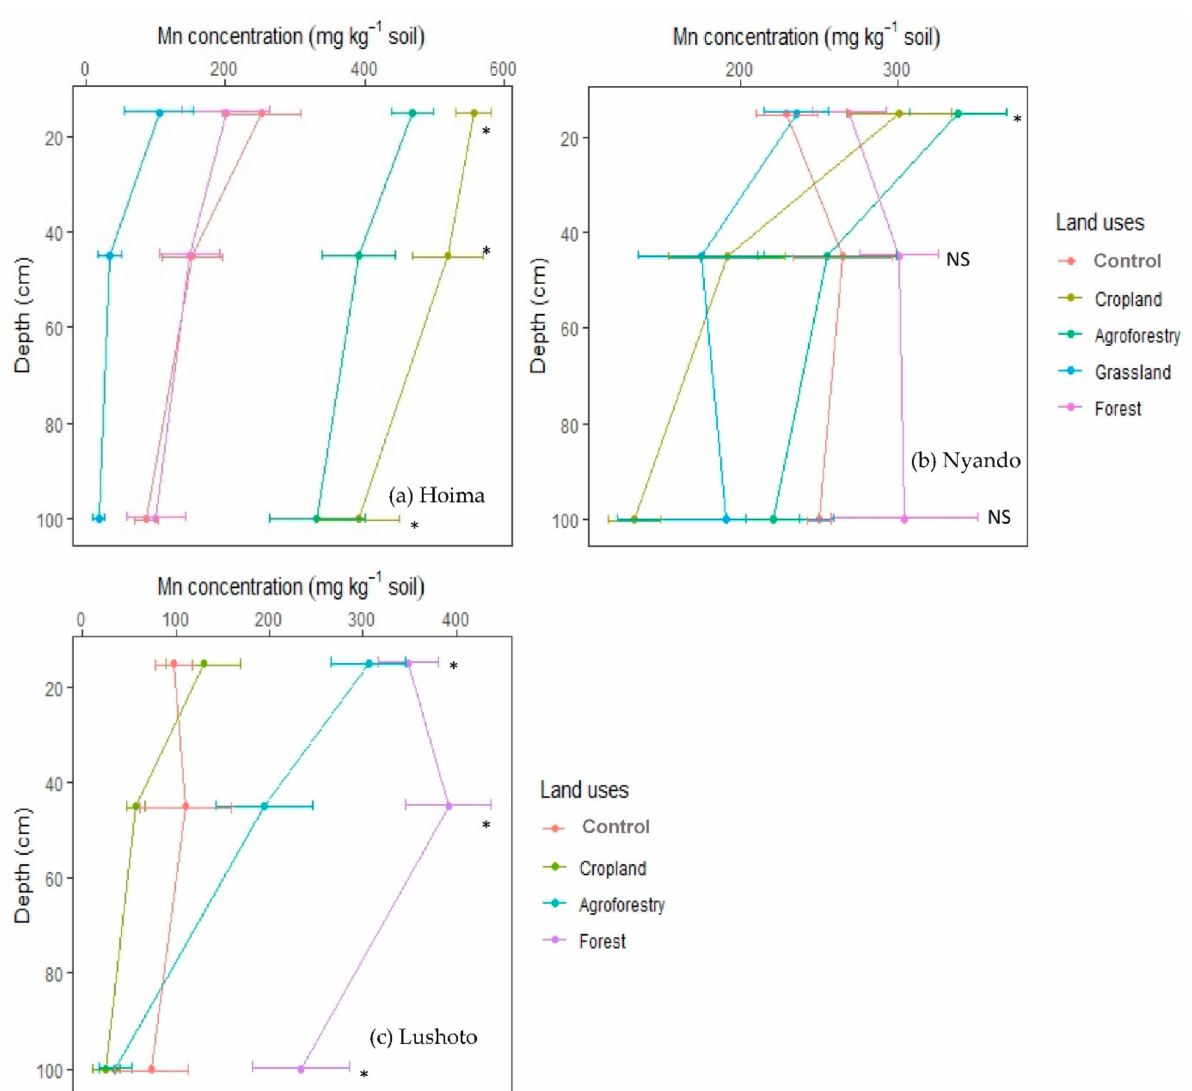
Figure 5. Manganese concentration in ( a ) Hoima, ( b ) Nyando and ( c ) Lushoto at different land uses: cropland, agroforestry, grassland, forest, and control at different soil depths. Error bars represent standard error of the mean. NS denotes nonsignificant differences; * denotes significant differences at p ≤ 0.05,